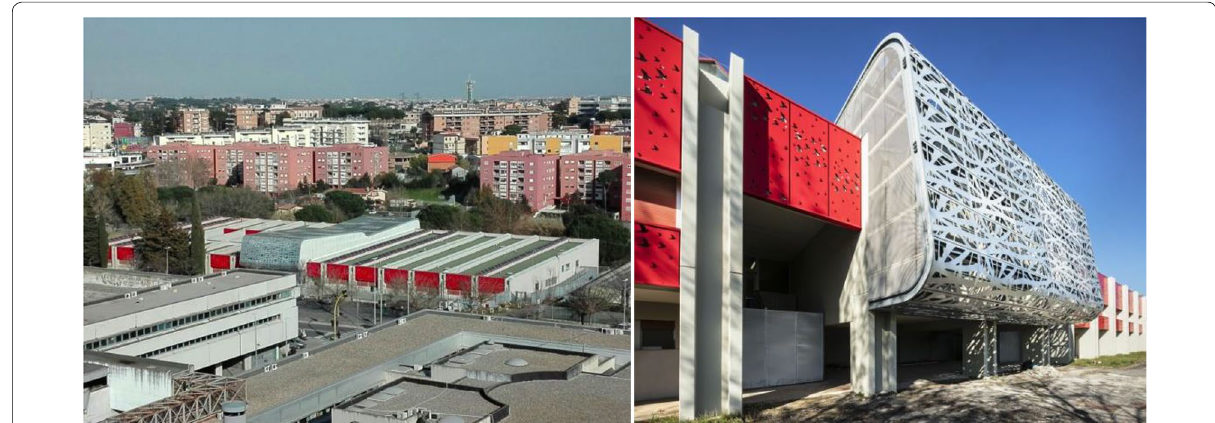
Fig. 8 The new Mazzacurati school in Rome designed by TStudio-G. Salimei. (Copyright TStudio—G. Salimei, photos L.